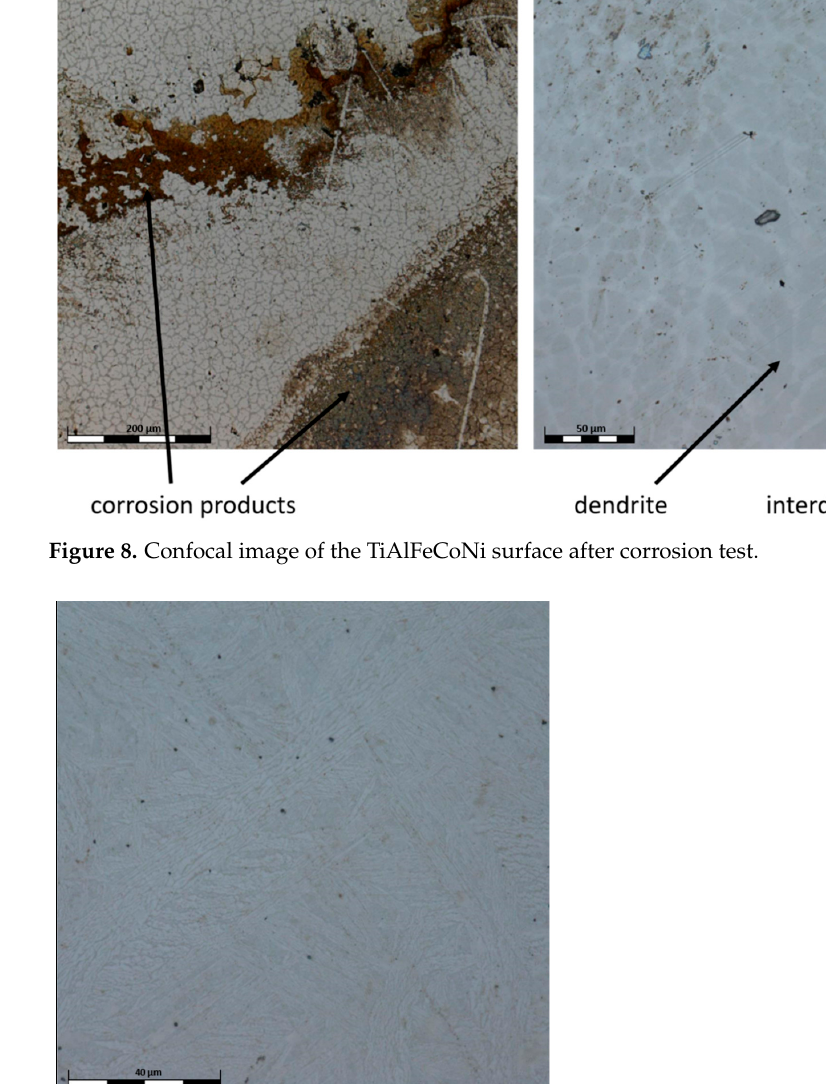
Figure 10. Confocal image of the Mn 0.5 TiCuAlCr surface after corrosion test. Figure 11. Confocal images of the CoCrFeNiCu surface obtained after the corrosion test: ( a ) low- magnification image, presenting the surface state of the sample, ( b ) high-magnification image, in which the corrosion stains in interdendritic areas are well discernible, ( c ) the color-scaled topogra- phy of image b; please note the depth of the periodically occurring corrosion pits.